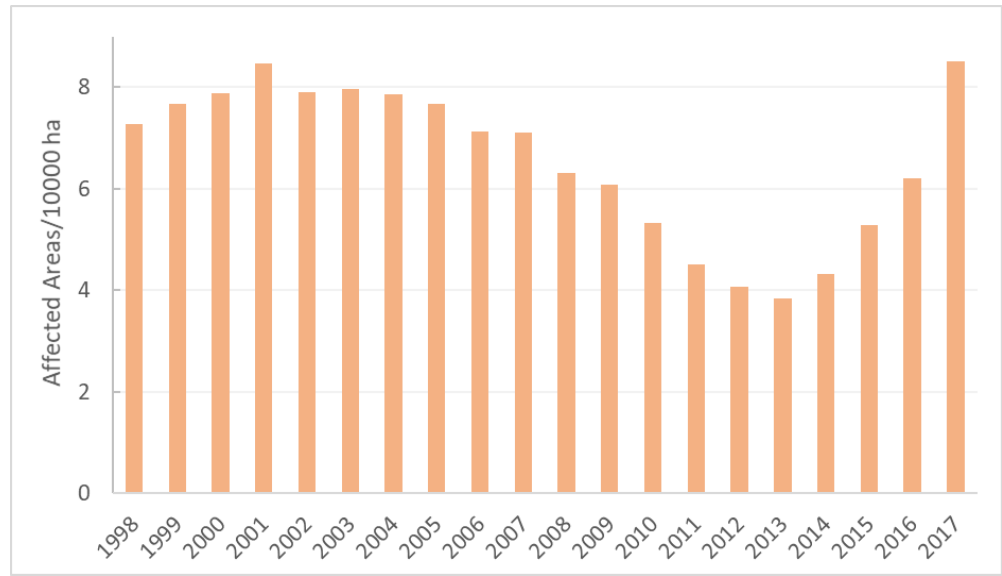
Figure 1. Trends in areas infected by pine wood nematode disease in mainland China from 1998 to 2017.